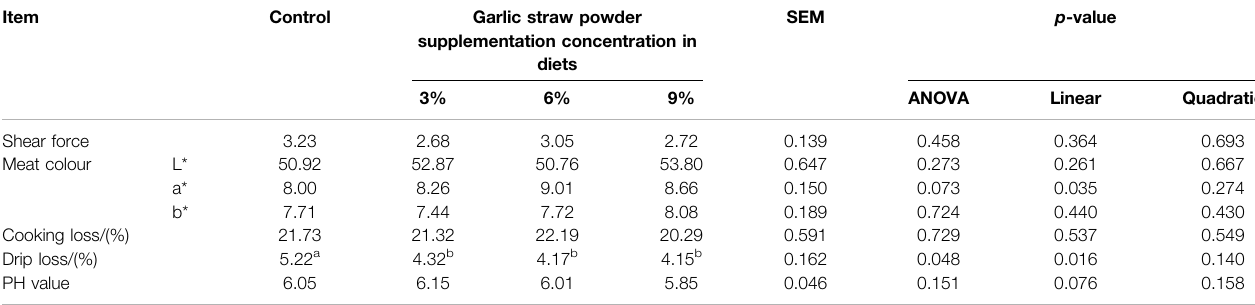
TABLE 3 | Effects of different dietary levels of garlic straw powder on breast muscle quality in yellow-feathered broilers (g).